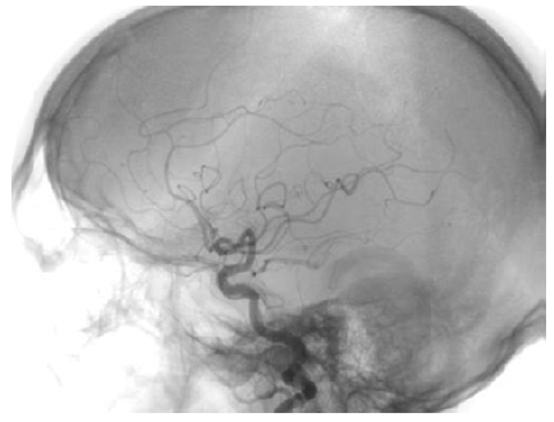
Figure 5. Intracranial control angiogram after procedure.